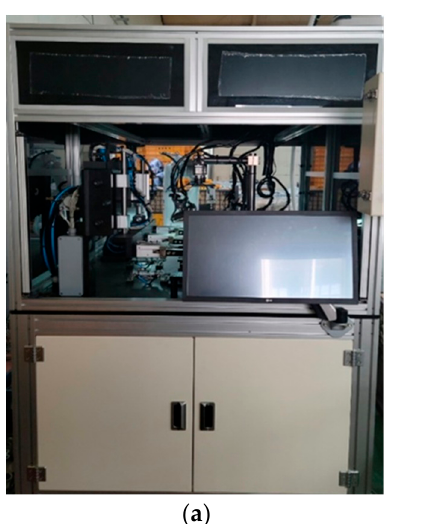
Figure 9. Illustration of the comparison of the proposed model performance in terms of processing time ( a ) and number of model parameters ( b ).